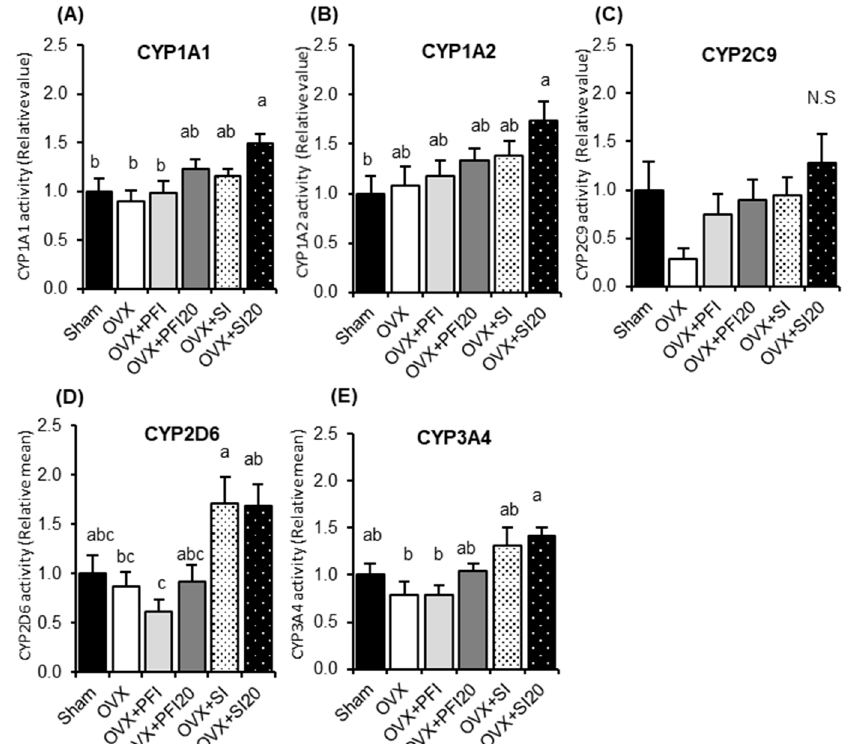
Figure 2. Hepatic activities of ( A ) CYP1A1, ( B ) CYP1A2, ( C ) CYP2C9, ( D ) CYP2D6 and ( E ) CYP3A4